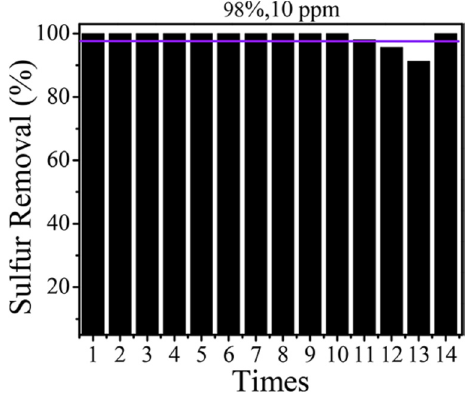
Figure 10. Recycling performance of MoOxNPs/g-BN. Reaction conditions: V (oil) = 20 mL, m (catalyst) = 0.1 g, T = 120 °C, v (air) =100 mL/min, t = 8 h [90].